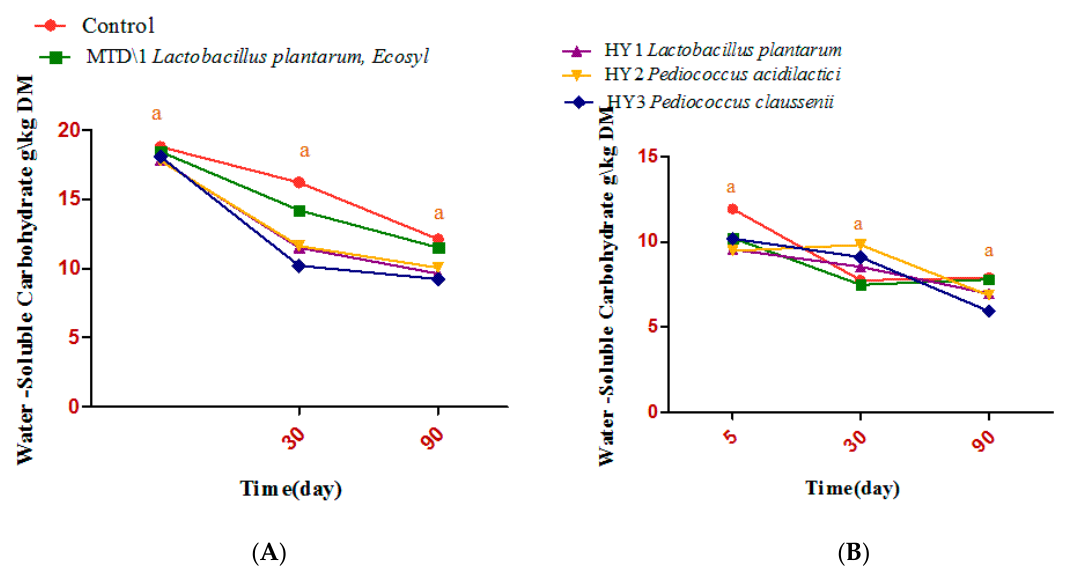
Figure 3. Effect of LAB inoculants on WSC converts ( A ) sweet sorghum, ( B ) Napier grass silage, during different opening times.